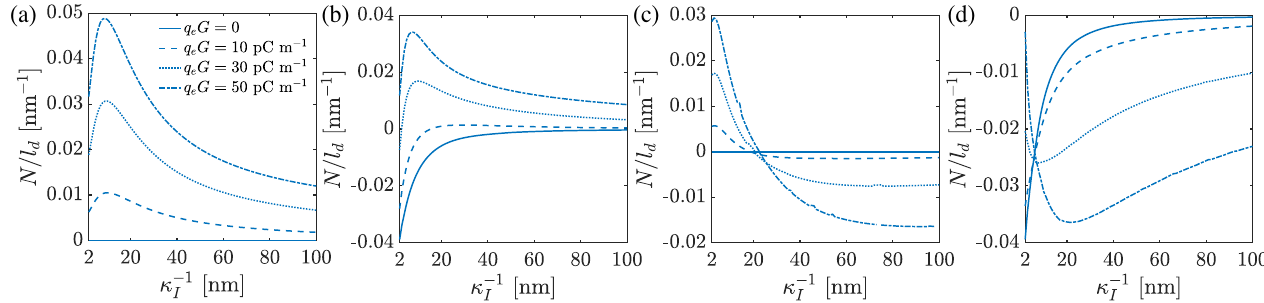
FIG. 7. Total charge number N per unit contour length l length κ − 1 . (a,b) For k ¼ − 1 = 2 and (c,d) k ¼ 1 = 2 defects, with (a,c) only flexoelectricity ( g I flexoelectric coefficient G and (b,d) with ion partitioning g